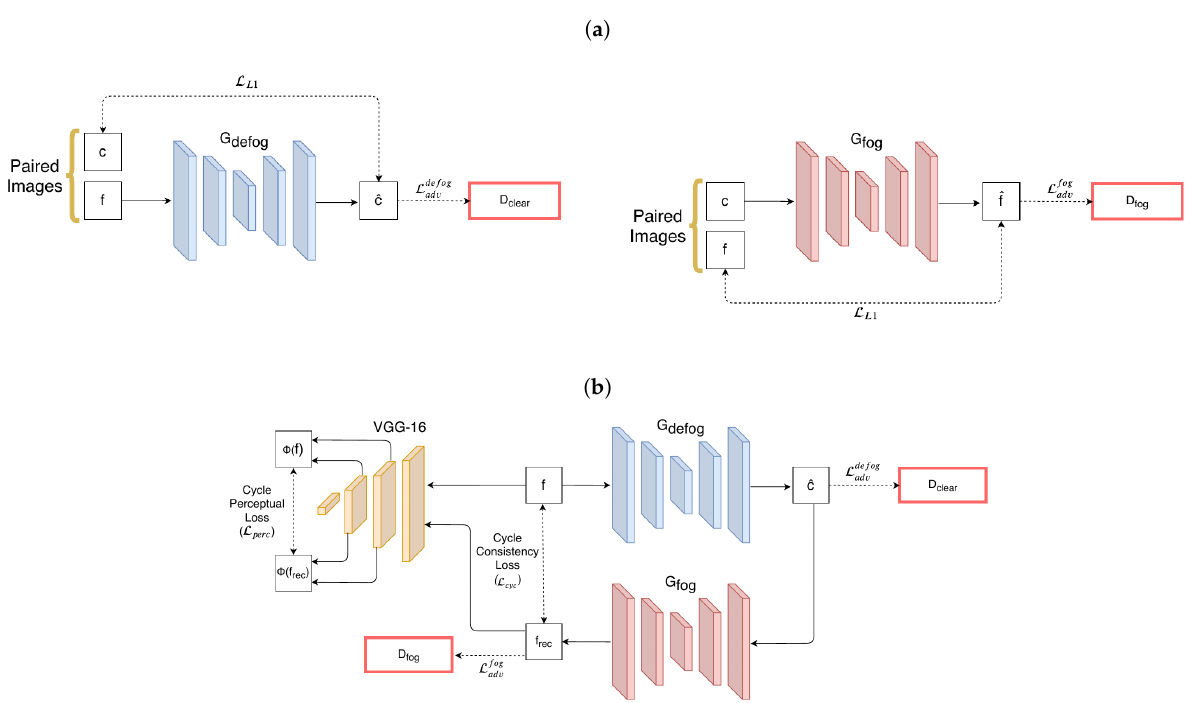
Figure 2. CurL-Defog architecture. ( a ) During the paired training, two separate pix2pix models are used: one for defogging and one for fogging images. ( b ) During the unpaired training, the two generators are used in combination to enforce the cycle consistency loss and the cycle perceptual loss; to keep the notation simple, the discriminators are depicted as rectangles, and in ( b ), only the defogging cycle is displayed, since the foggy cycle (starting from the clear image) is symmetrical and can be easily derived. For each training epoch, the model behaves as in ( a ) for a subset of the training iterations, and as in ( b ) for the rest of the iterations.